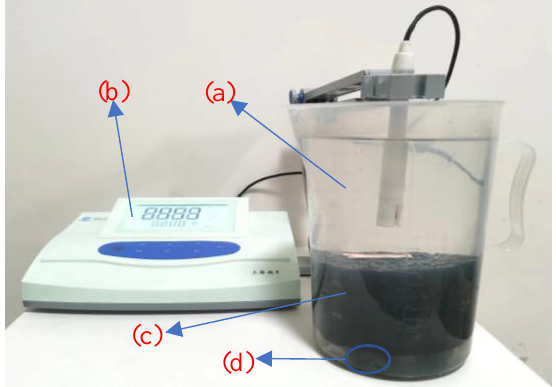
Figure 3. Diagram of salt precipitation test by full dissolution method: ( a ) 1500 mL drinking water; ( b ) DDS-11A conductivity meter; ( c ) Marshall specimen; ( d ) three stones.